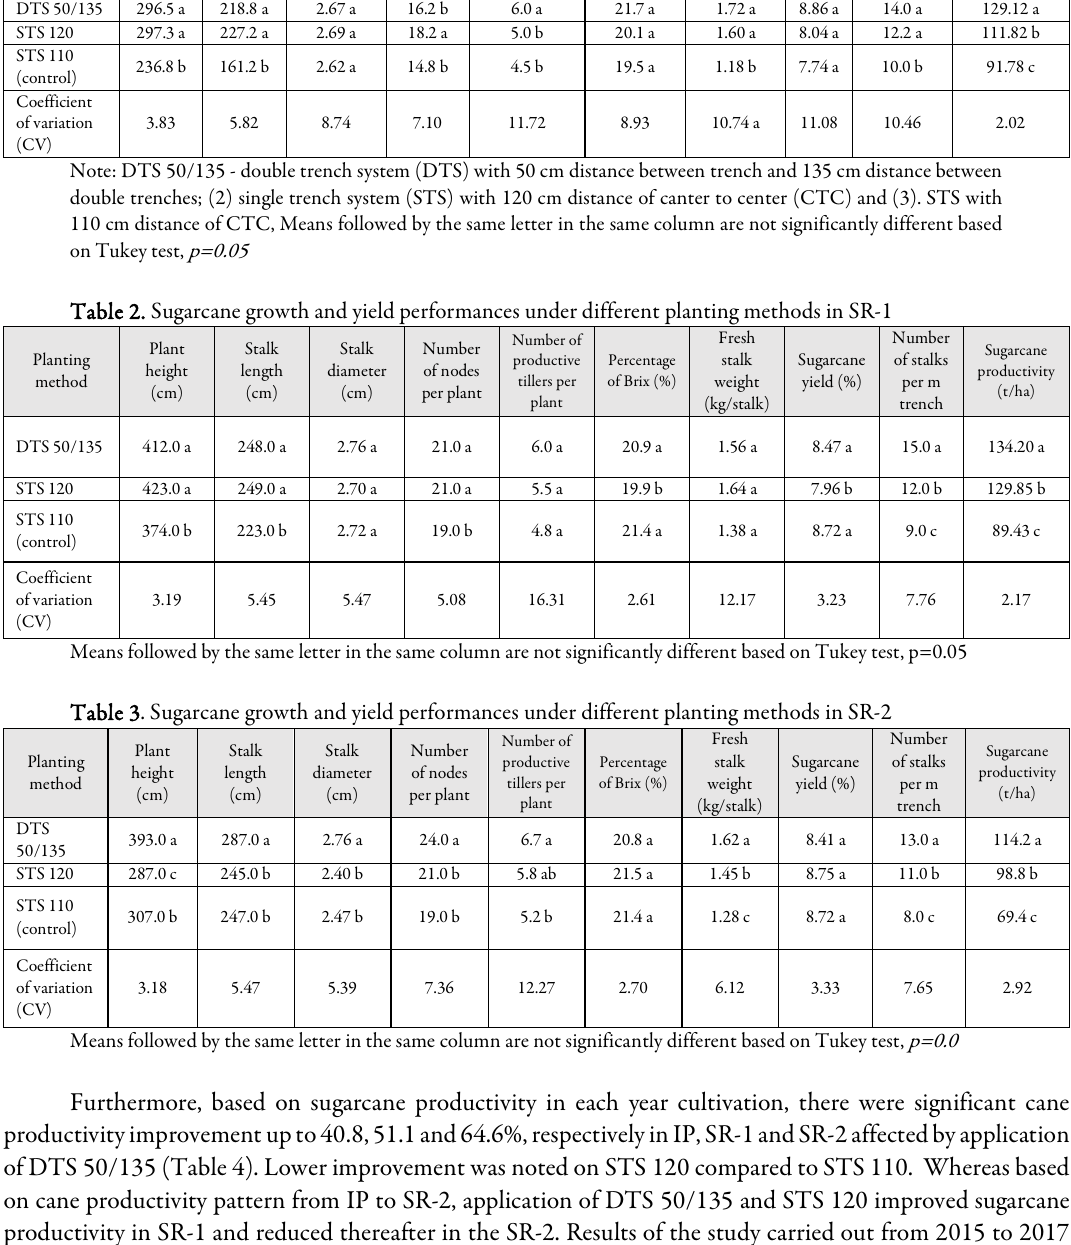
Table 1. Cane growth and yield performances under different planting methods in the initial planting Planting method